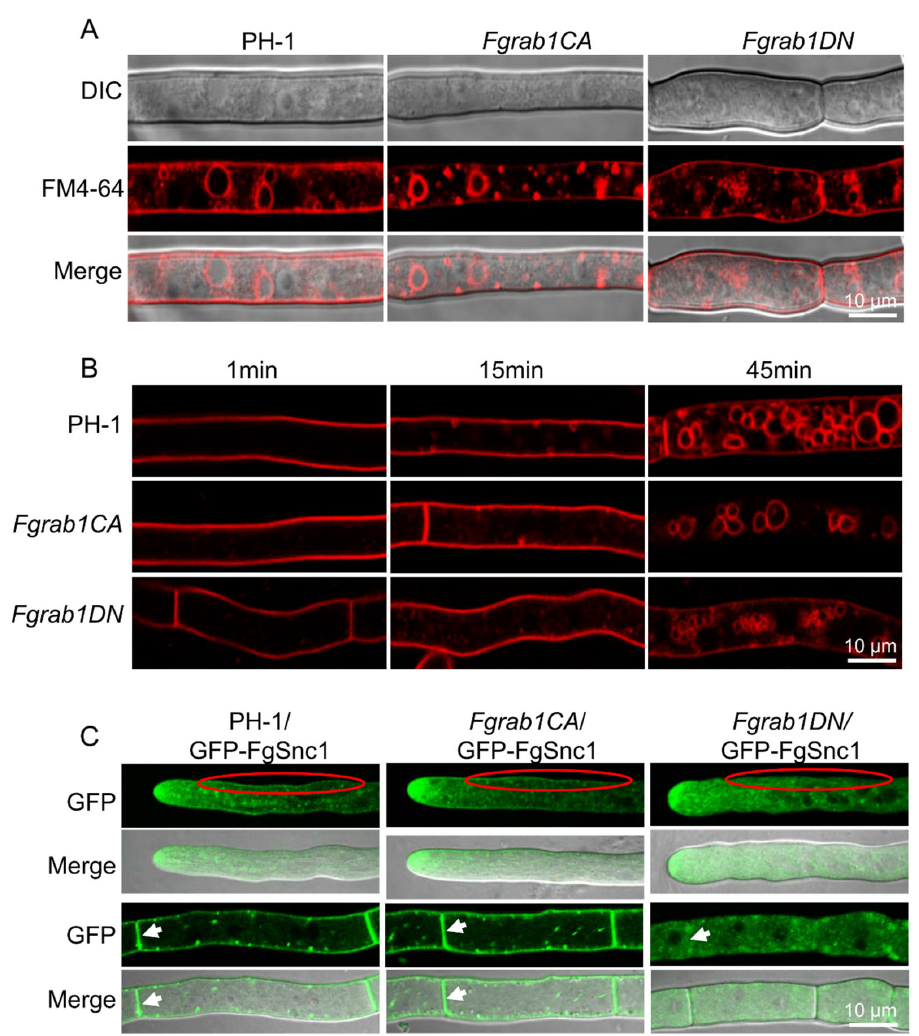
Figure 5. FgRab1 inactivation disrupts the transport of FgSnc1 to the plasma membrane and the fusion of vesicles with target membranes in F. graminearum . ( A , B ) FgRab1 is necessary for membrane fusion. ( C ) FgRab1 is required for the transport of FgSnc1 to the plasma membrane and septum. Red circles show the plasma membrane localization of GFP ‐ FgSnc1, and white arrows show the septum localization of GFP ‐ FgSnc1, bar = 10 μ m.